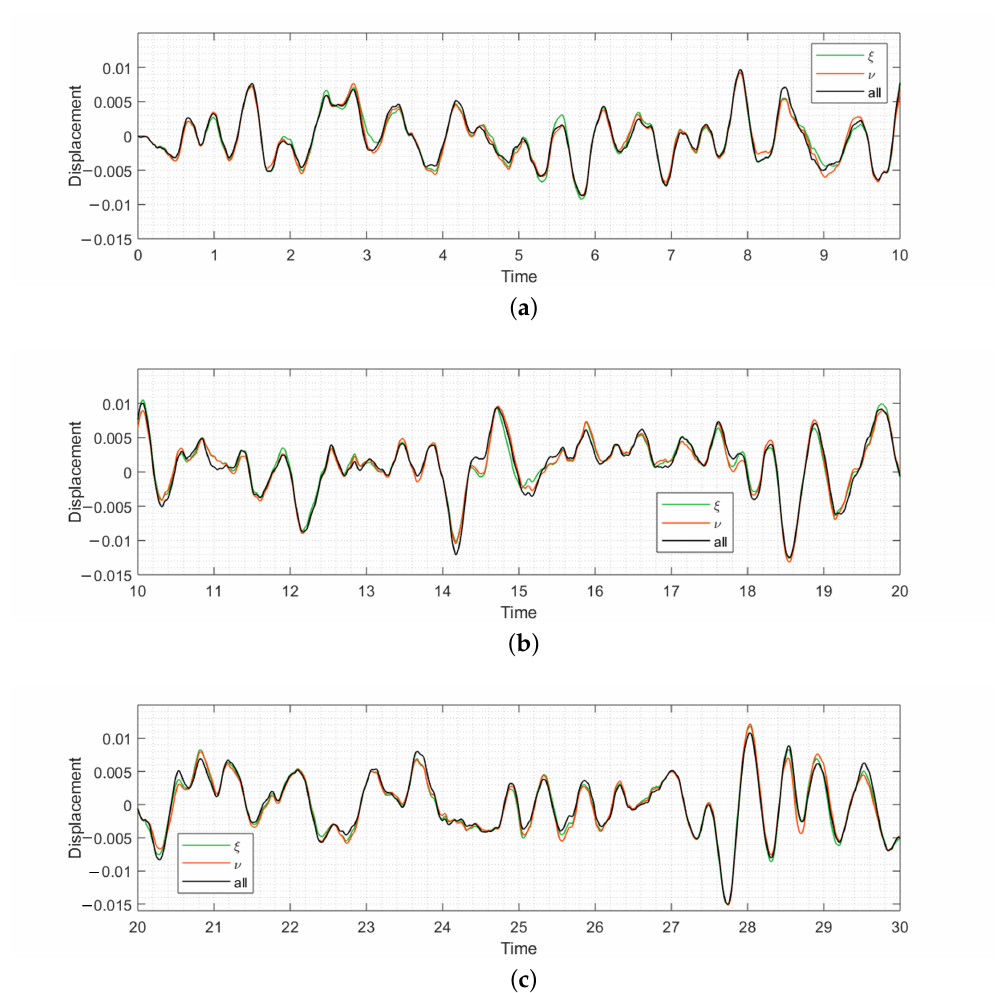
Figure 14. The time history of three cases based on particle swarm optimization ( ξ , ν ,